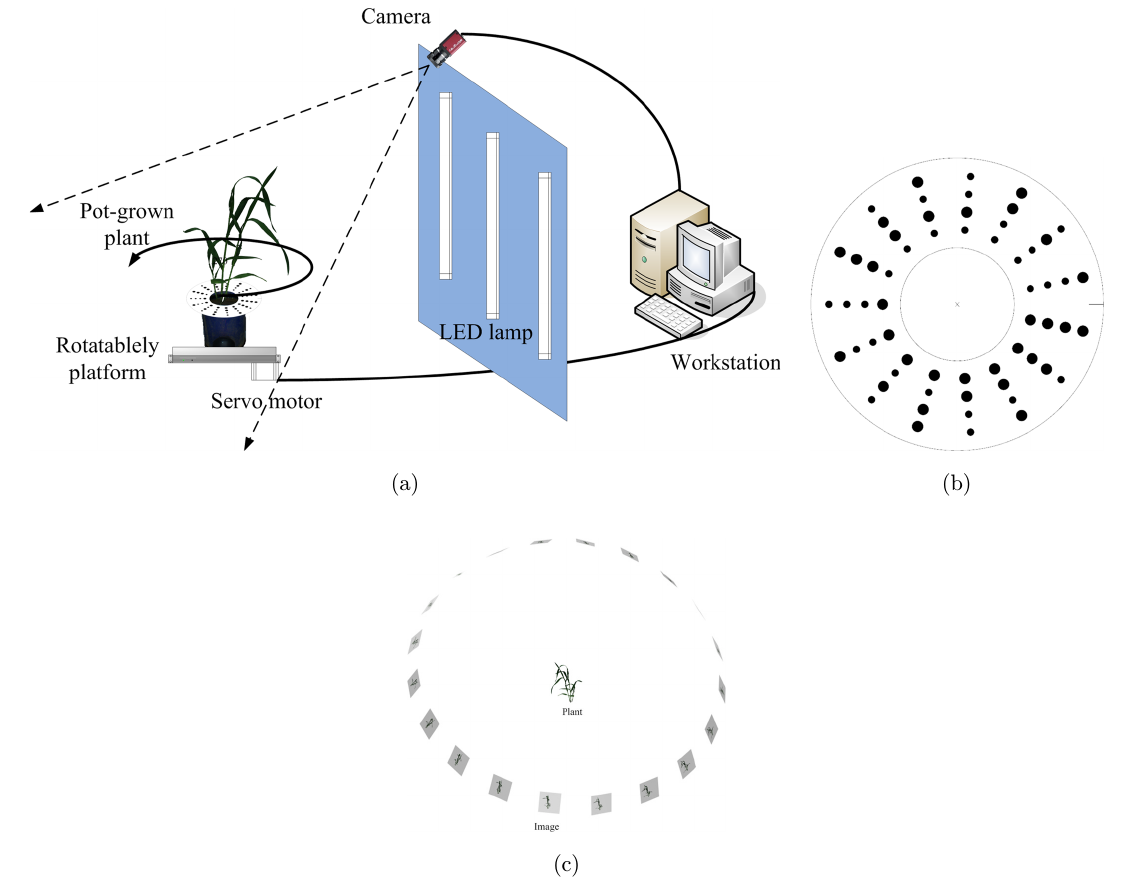
Fig. 2. (a) Schematic diagram of the system used for image acquisition. (b) Calibration pattern. (c) 20 images of the